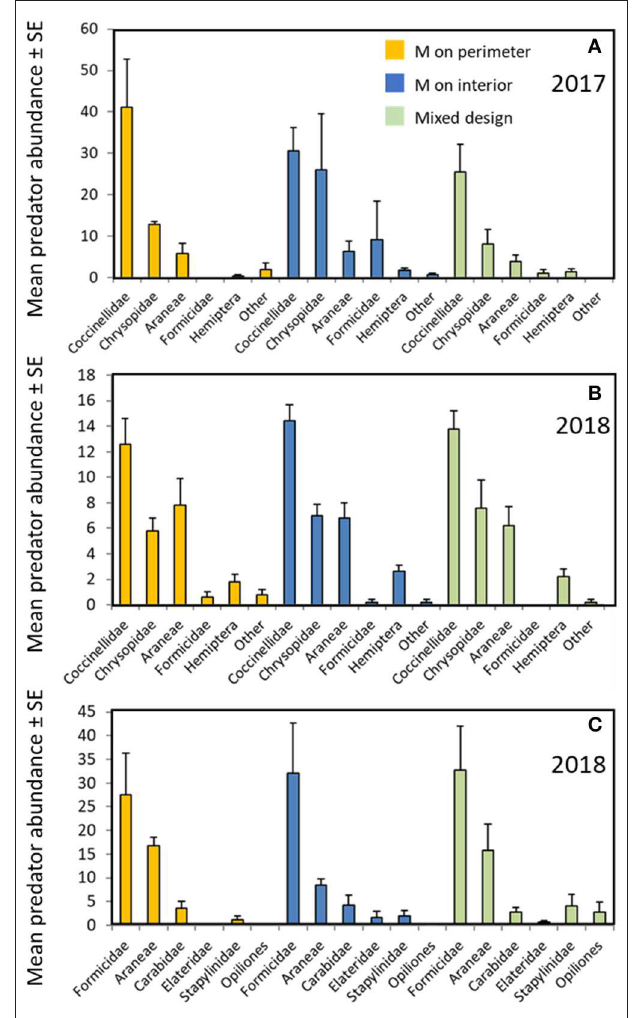
FIGURE 4 | Predator abundance by garden design; Milkweed (MW) on perimeter (orange), Milkweed on interior (blue), Milkweeds intermixed (green). (A) Predator groups observed on host plant foliage in gardens (2017); (B) Predator groups observed on host plant foliage in gardens (2018); (C) Predator groups collected in pitfall traps in the gardens (2018). Counts are means ± (SE) per garden treatment combined. Garden design did not significantly affect counts of any predator group (ANOVA, all P ≥